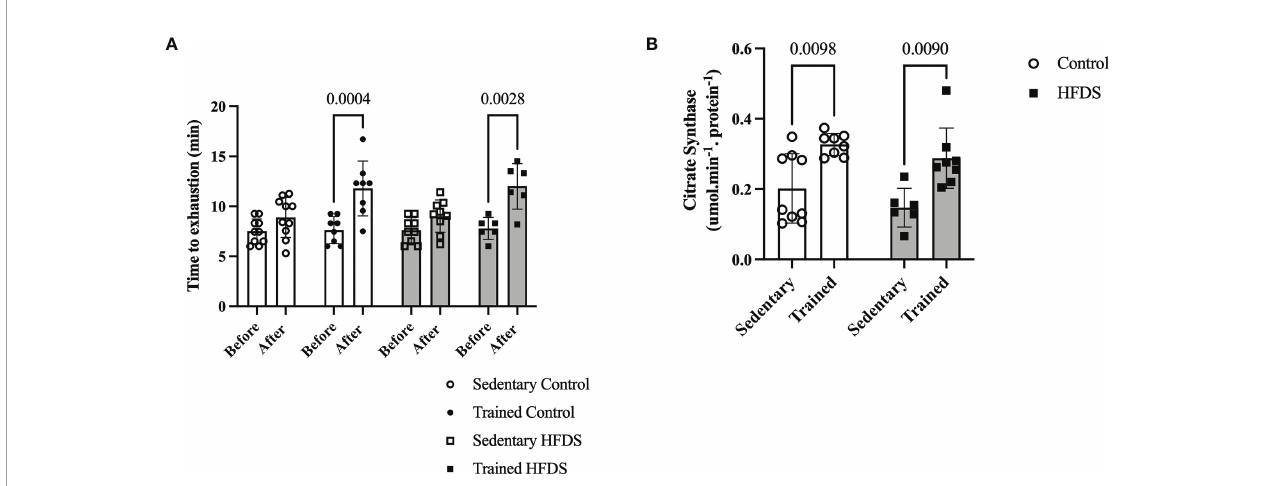
FIGURE 2 | Effects of endurance training on exercise capacity (run-to-exhaustion time). (A) C, CTR, HFDS and HFDSTR (week 0 vs . after week 8). Differences in CTR and HFDTR between week 0 vs . 8, respectively (P<0.01). (B) Citrate Synthase Activity in the gastrocnemius muscle of C, CTR, HFDS and HFDSTR after eight weeks: Endurance training effect (P<0.01). Data are expressed as the mean ±